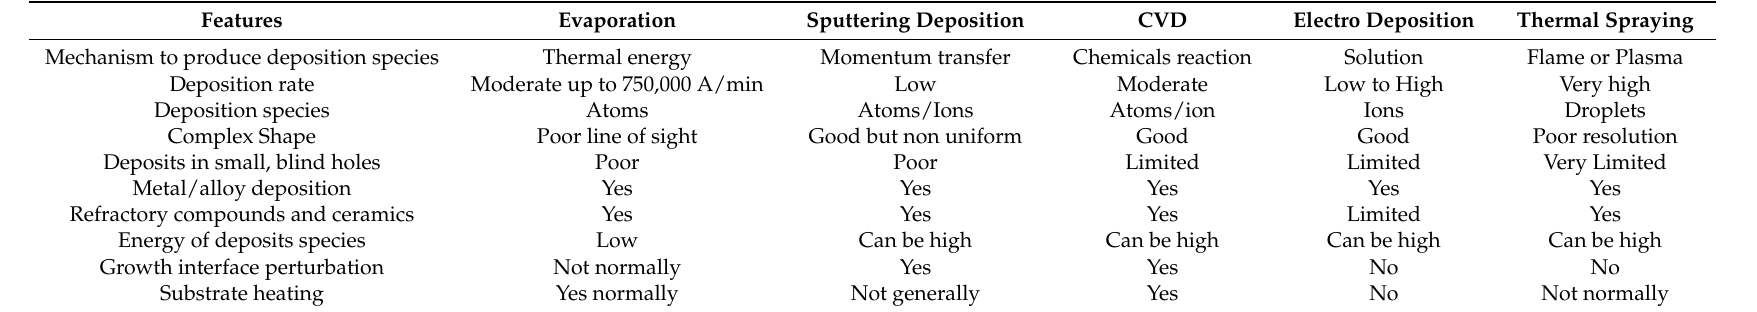
Table 2. Summary of the benefits and limitations of the atomistic and particulate deposition methods